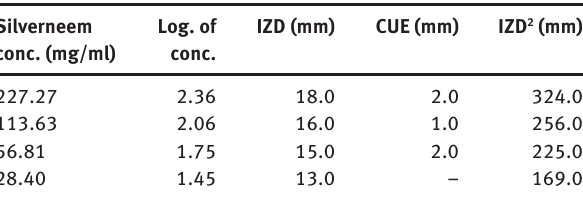
Table 2: Effects of varying concentrations and log concentration on IZD, CUE, and IZD 2 of silverneem on Lasiodiplodia theobromae. Silverneem Log. of conc. (mg/ml)